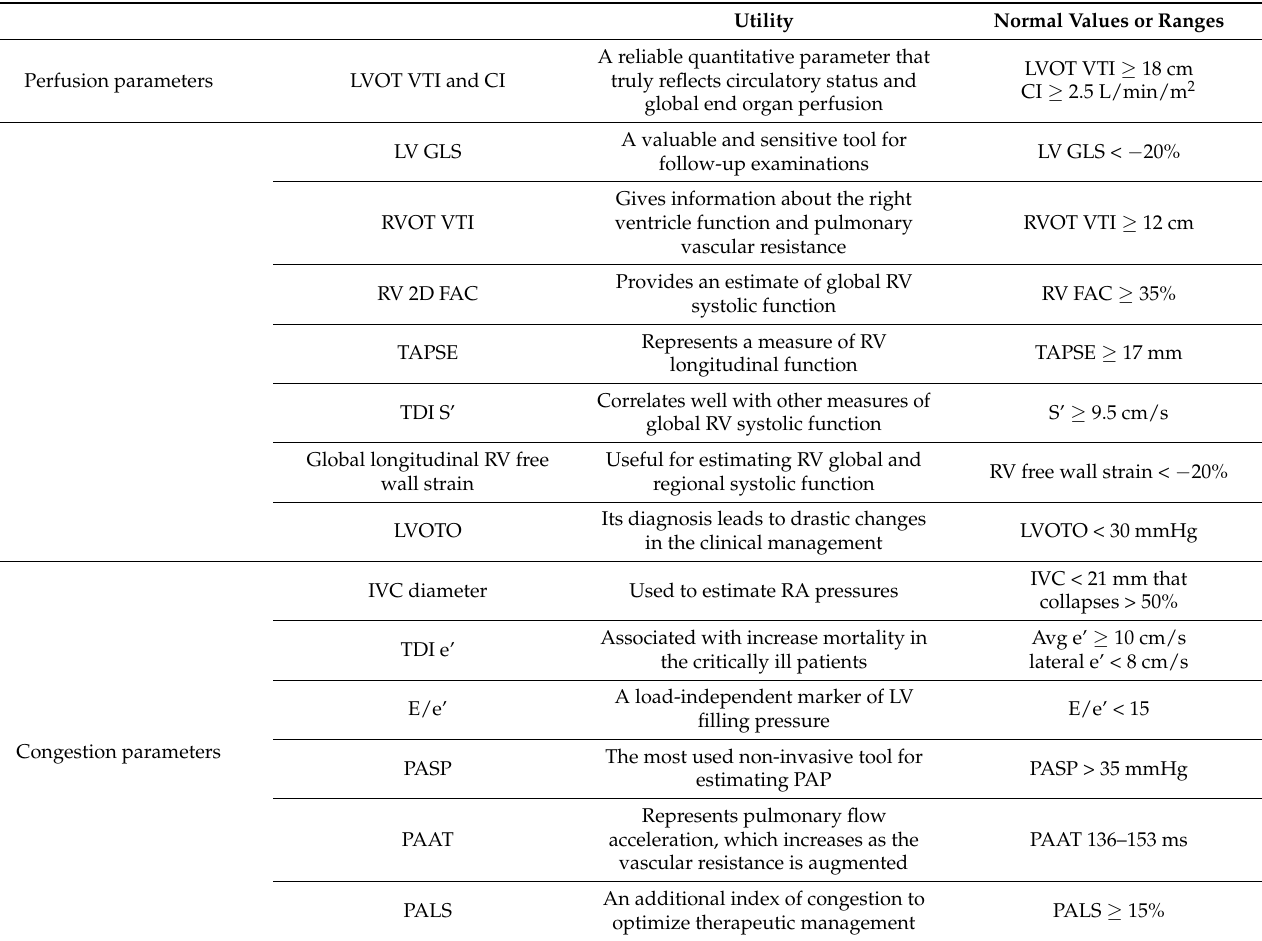
Table 1. Echocardiographic indices of perfusion and congestion in patients in CICU, detailed on the basis of their utility and normal values or